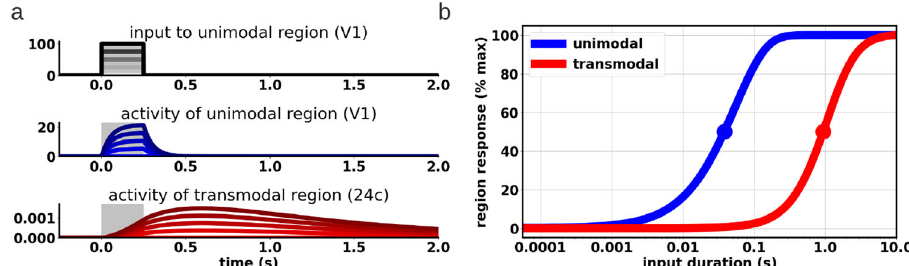
Fig. 6 Distinct neural timescales from input perturbations. a Activity of primary visual cortex (V1) and anterior cingulate cortex (24c) in response to 250 ms of pulse input of varying strengths to area V1. The unimodal region V1 exhibits fast, short-lasting responses, whereas the transmodal region 24c exhibits slower, long-lasting responses. b Input duration is differentially regulated by unimodal and transmodal regions. The unimodal region V1 shows rapid response saturation to brief input durations, re fl ecting fast integration of sensory-relevant stimuli. The response of the transmodal region 24c saturates over longer timescales, re fl ecting slow and delayed temporal integration